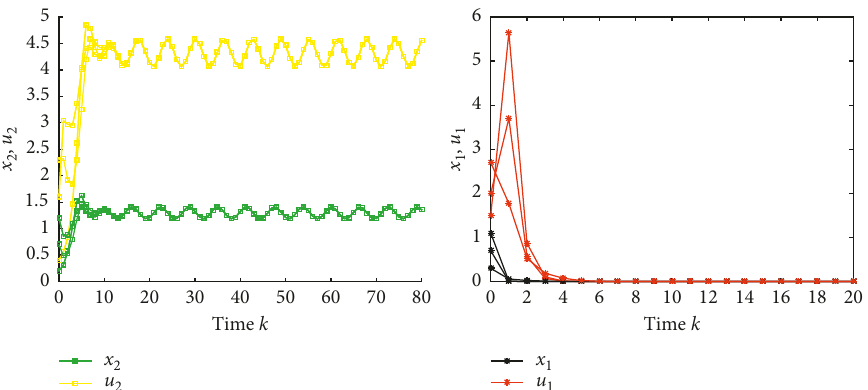
Figure 2: Numeric simulations of the solutions x s ,x s ,u s ,u s 1 ( 2 ( 1 ( 2 ( ( ) ) ) ))(cid:31) (